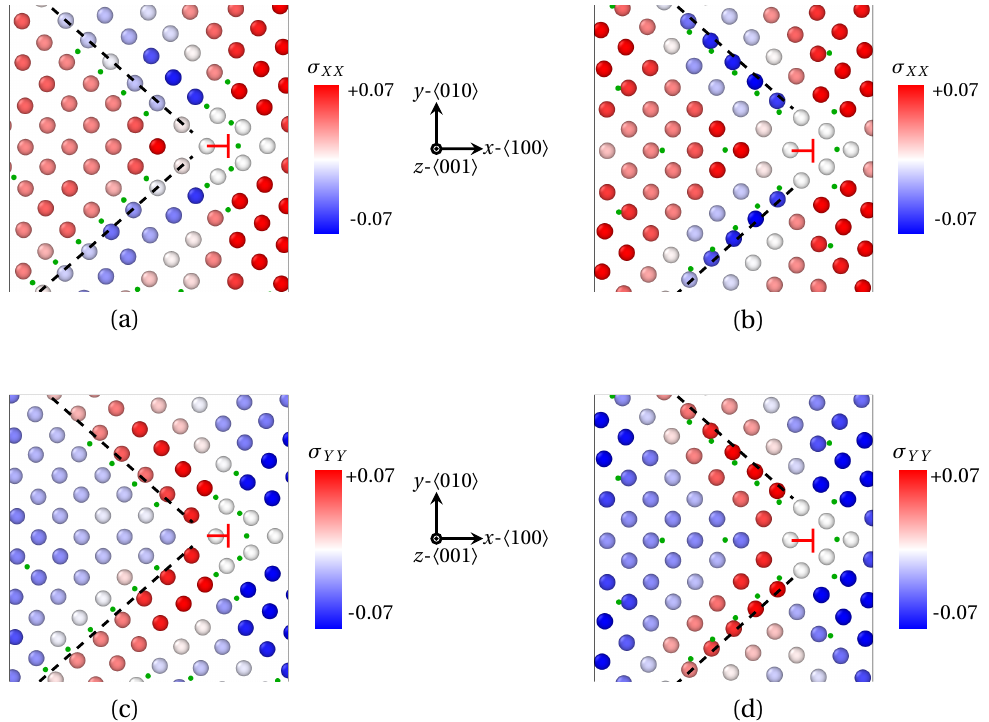
Figure 6. Strain field in the vicinity of one (cid:104) 100 (cid:105) edge dislocations after segregation of X 1 ( a , c ) and X 2 ( b , d ) atoms at a low angle GB ( θ = 7.15 ◦ for X 1 and θ = 9.53 ◦ for X 2 , as provided by QA simulations ( t = 400). ( a , b ) Strain field σ XX in the (cid:104) 100 (cid:105) direction (red: tension in the x direction, blue: compression in the x direction). ( c , d ) Strain field σ YY in the (cid:104) 010 (cid:105) direction for X 2 (red—tension in the y direction, blue—compression in the y direction). X atoms are spotted by green dots for the sake of clarity. Black dashed lines: guide for the eye for the preferential area of